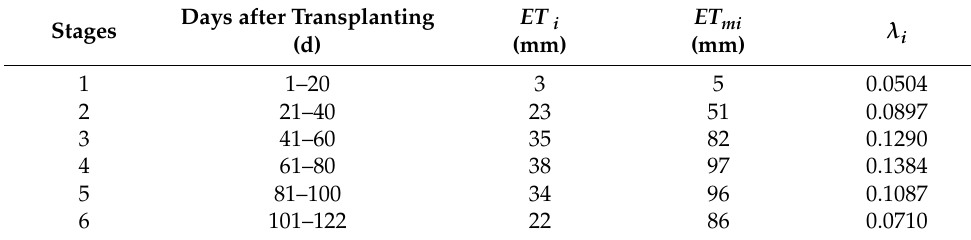
Table 6. The division of tomato growth